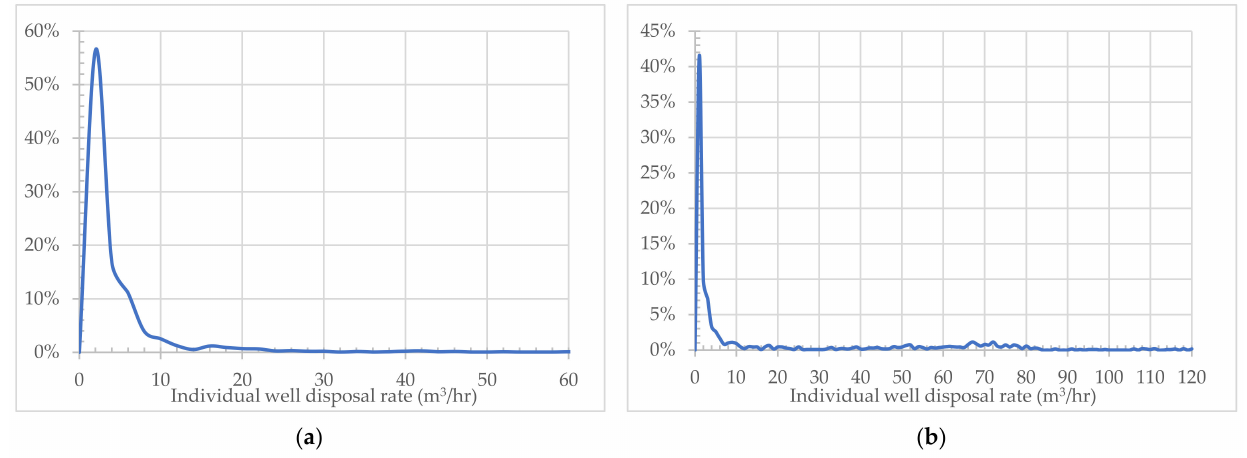
Figure A12. Historical per-well water injection rate ( X -axis) frequency ( Y -axis) distributions (January 1962–December 2022) in ( a ) the Bluesky Formation; ( b ) the Wabiskaw Sandstone